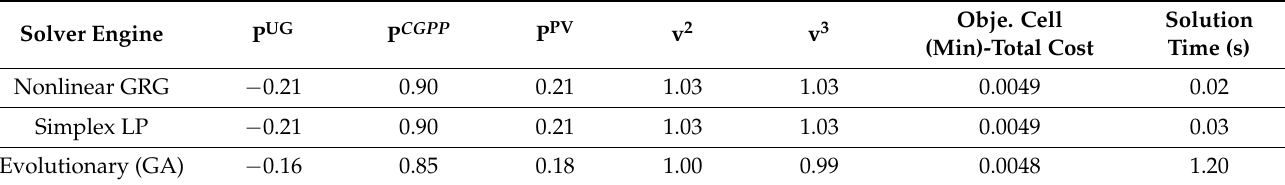
Table 8. Result summary of Excel solver methods in